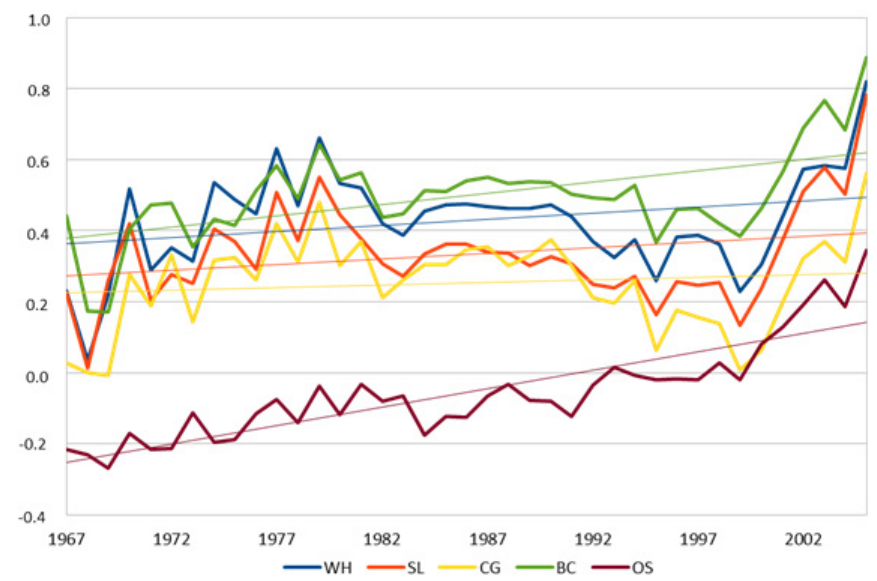
Figure 2. The trend of genetic indexes in the studied traits by year of birth.